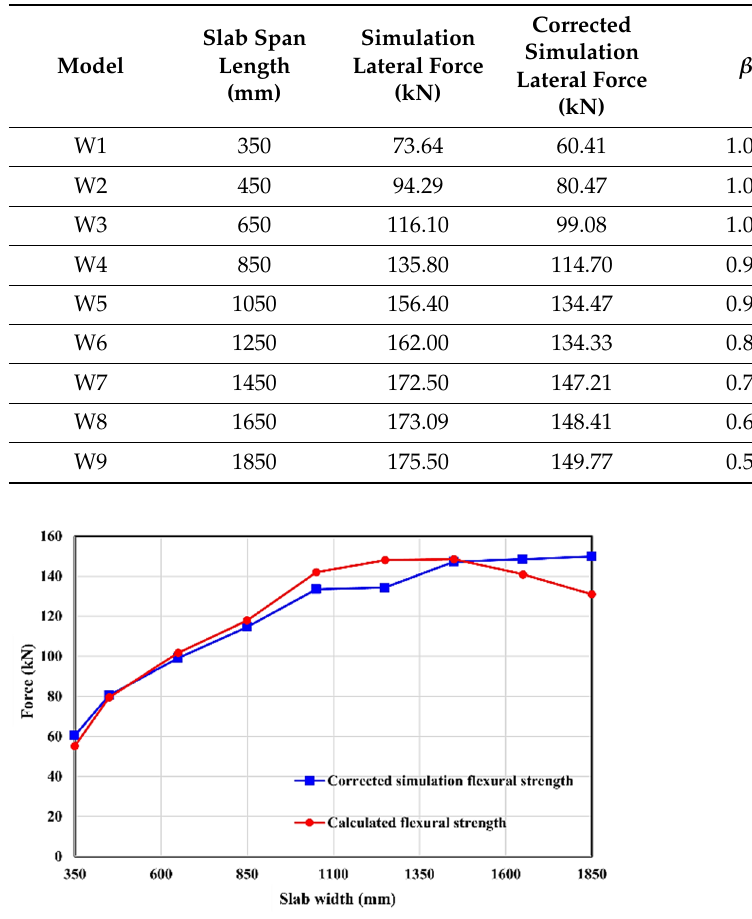
Table 2. FEM results for slab width models.